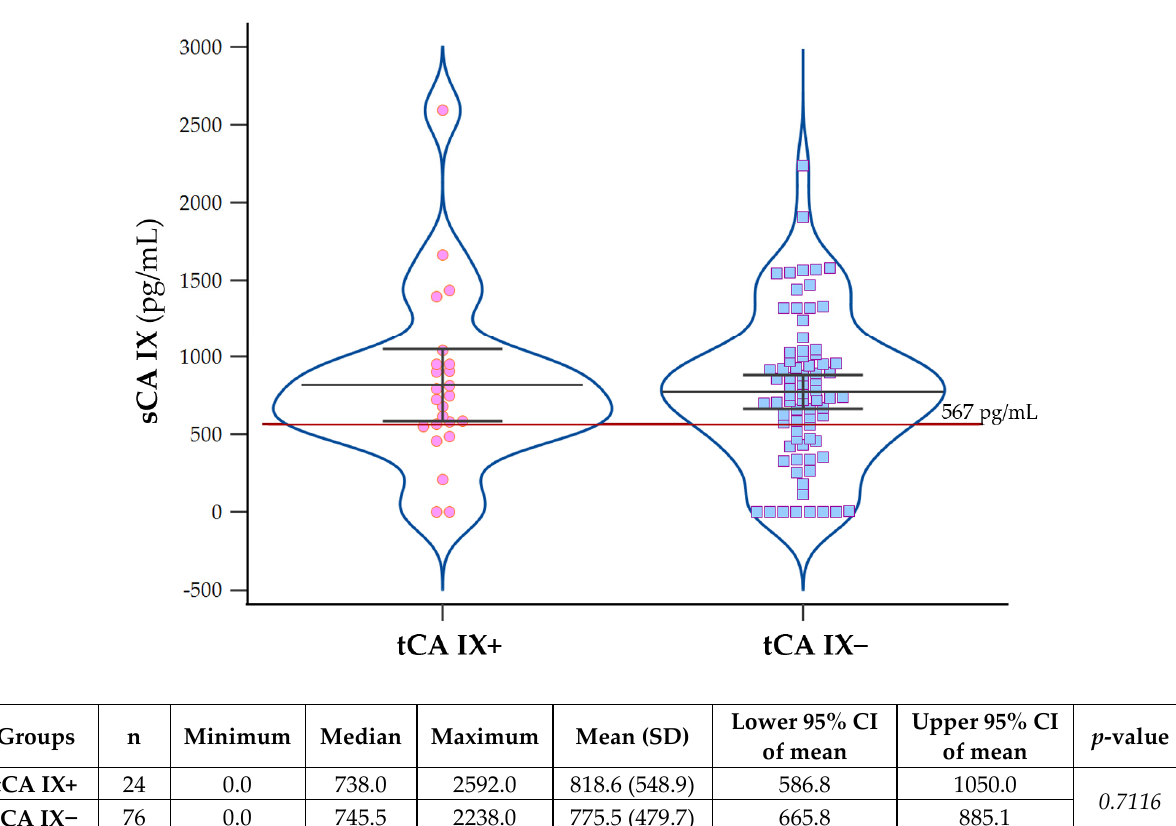
Figure 3. Analysis of sCA IX levels in plasma of patients with CA IX-positive versus CA IX-negative tissue. Violin graphs with dots (plot all data) showing the distribution of sCA IX levels (pg/mL) in tCA IX+ and tCA IX- groups determined by IHC. The table shows summary statistical data of sCA IX (pg/mL) for each group: number of patients (n), minimum, median, maximum, mean with standard deviation (SD), lower 95% confidence interval (CI) for mean, upper 95% CI for median, and result of unpaired t -test ( p = 0.7116 ).